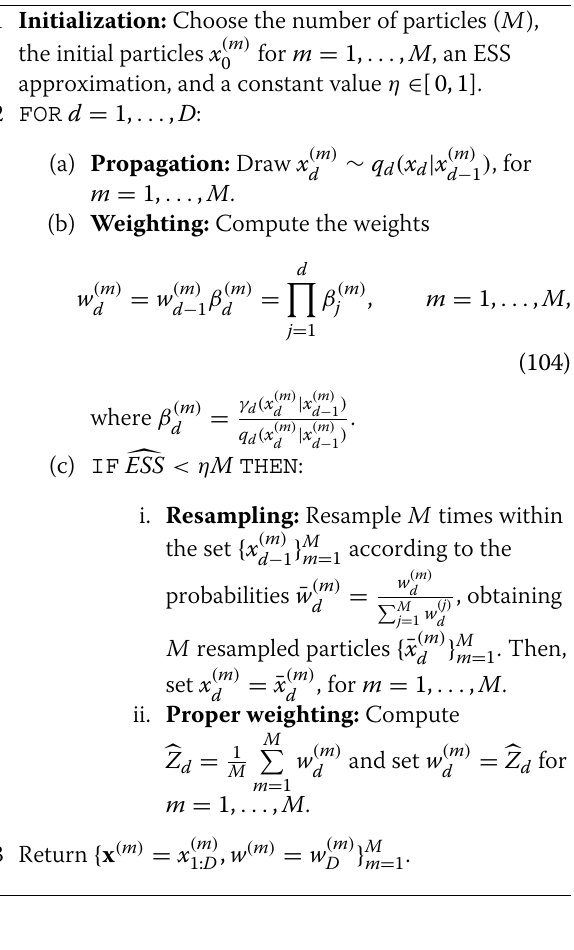
Algorithm 19 Sequential importance resampling